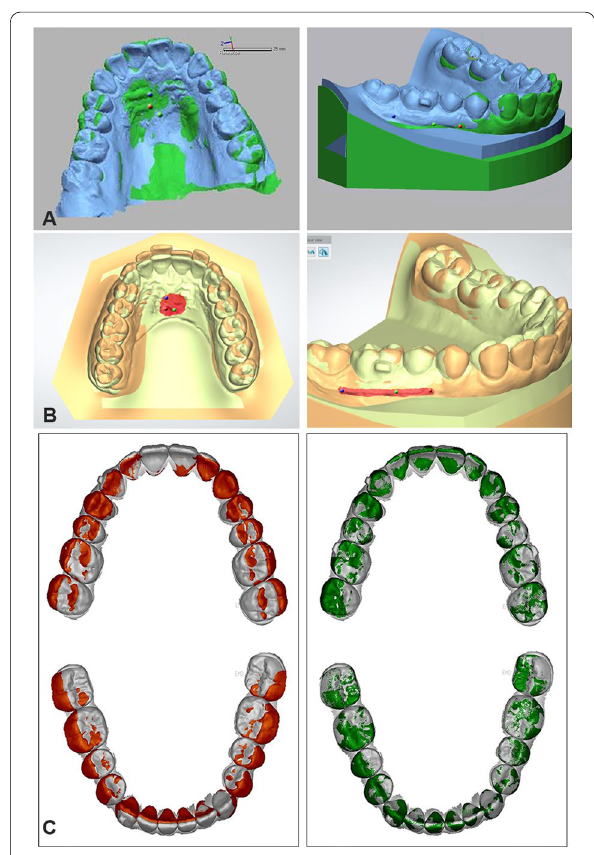
Fig. 2 Registration of maxillary and mandibular models by ( A ) S‑BF ( B ) I‑SB ( C )